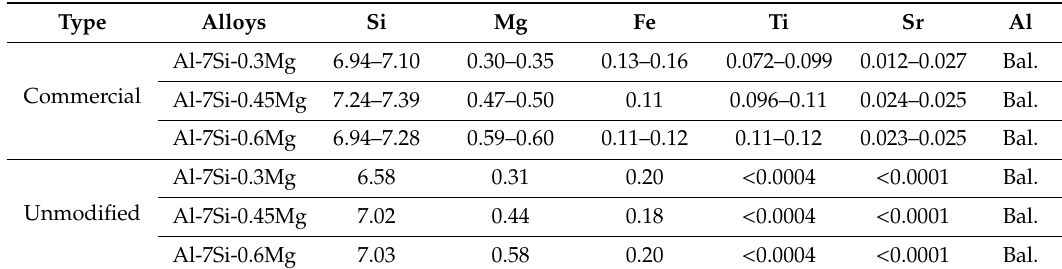
Table 1. Average chemical composition of the Al-7Si-Mg alloys used in this study. Compositions are in weight %. Type Alloys Si Mg Fe